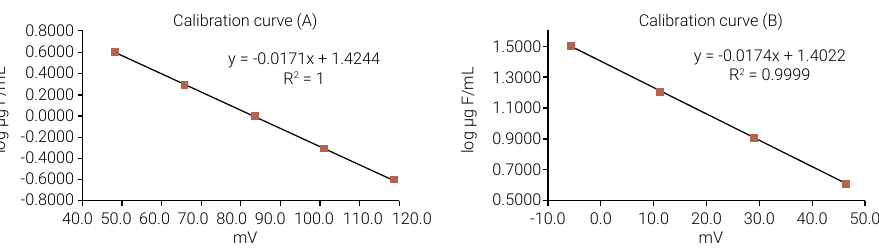
Figure 2. Calibration curves (n=3) and data of the correlation between the logarithm of fluoride concentrations in standards and the relative mV generated for the conventional (A) and simplified (B) protocols of analysis.